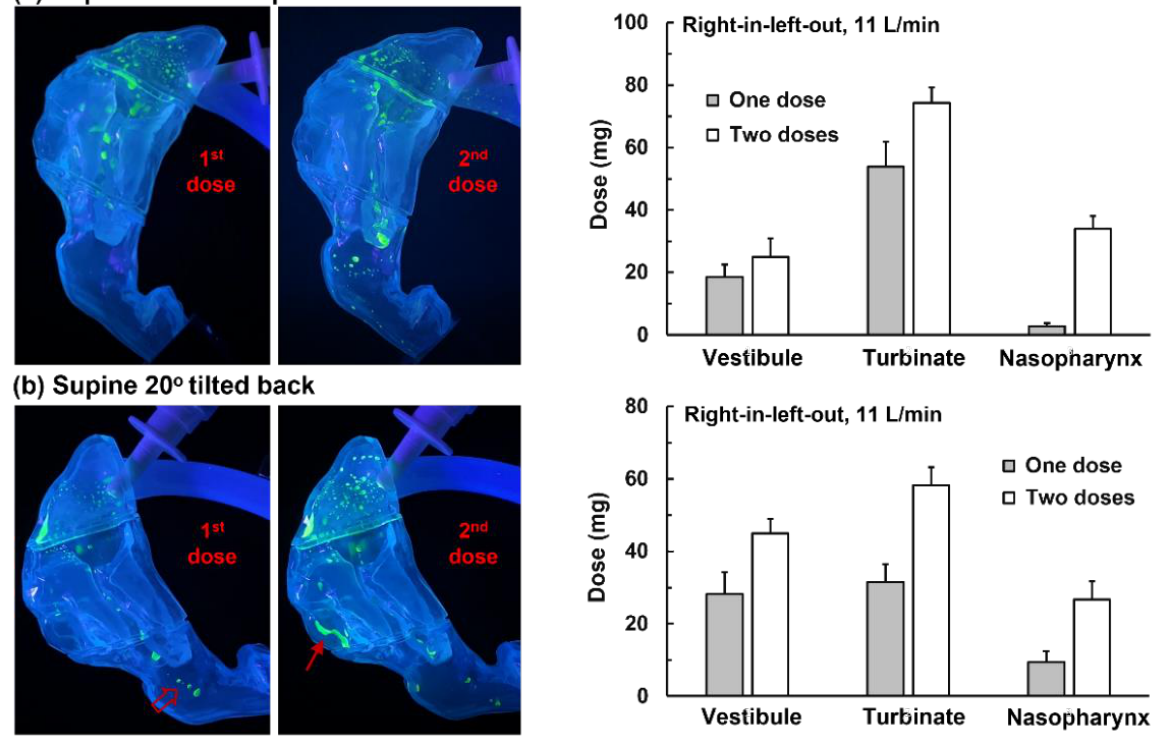
Figure 7. Head orientation effects on nasal spray deposition distribution: ( a ) supine 20° tilted up (head on a pillow) and ( b ) supine 20° tilted back.